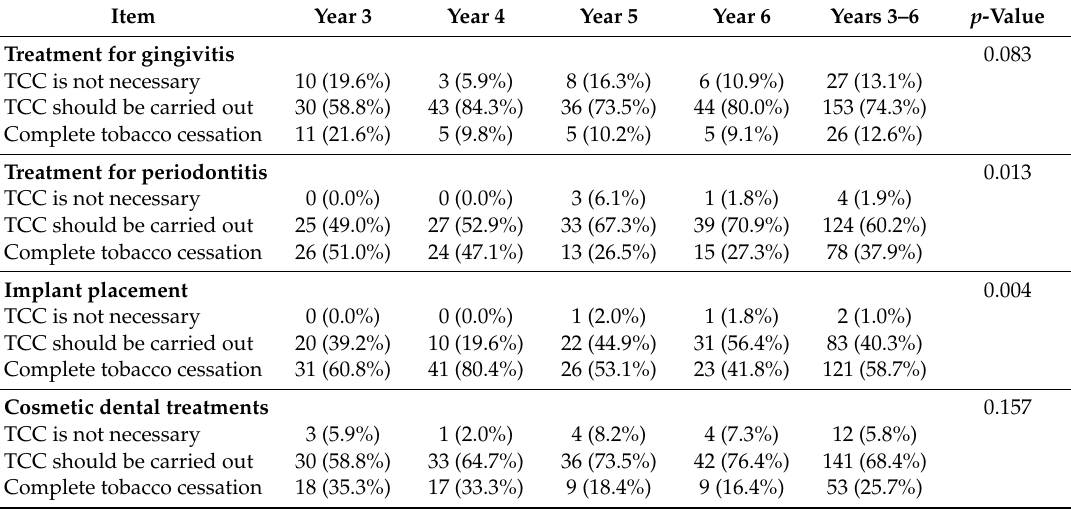
Table 5. Views of Hong Kong dental students toward the need of tobacco cessation counselling (TCC) and quitting tobacco use before dental treatments ( n =